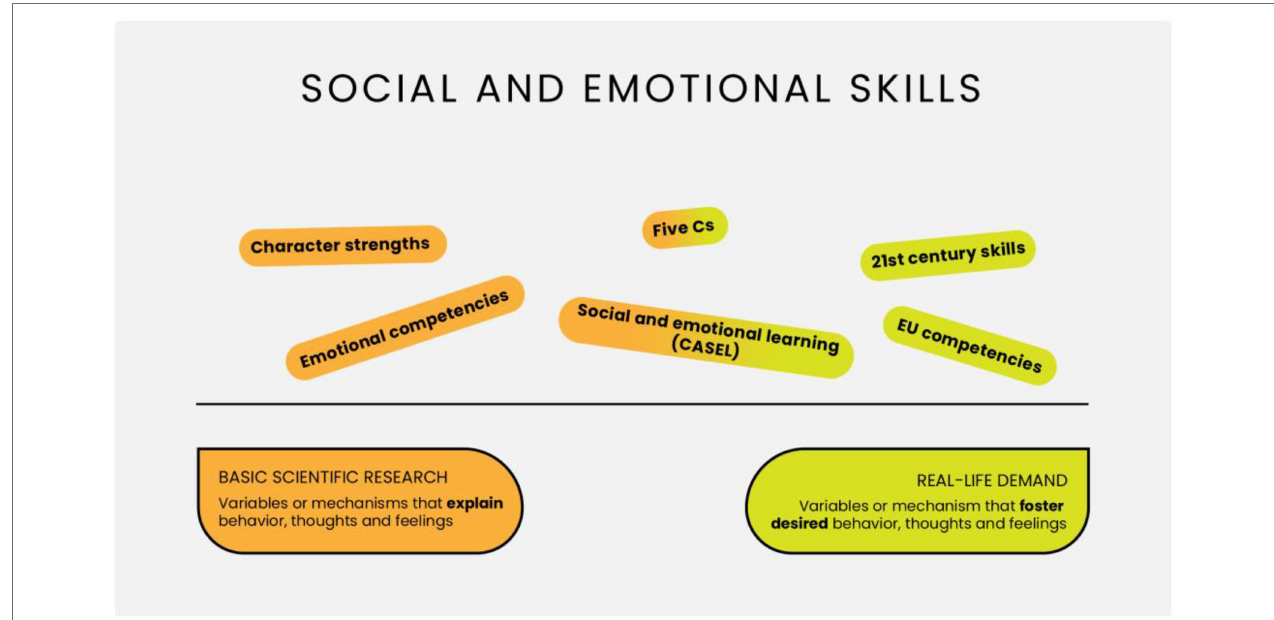
FIGURE 1 | The dual genesis of various types of skills